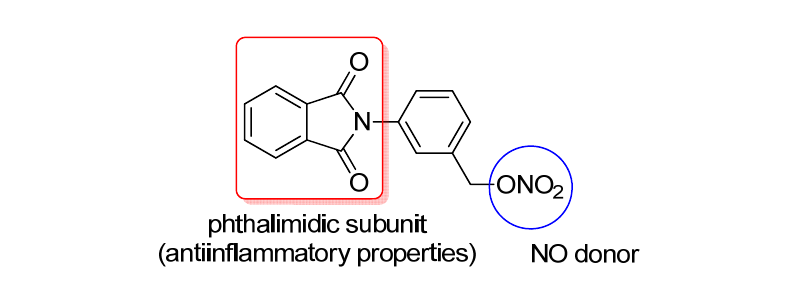
Figure 7. Hybrid of TNF- α inhibitor/NO donor for the treatment of sickle cell disease symptoms.